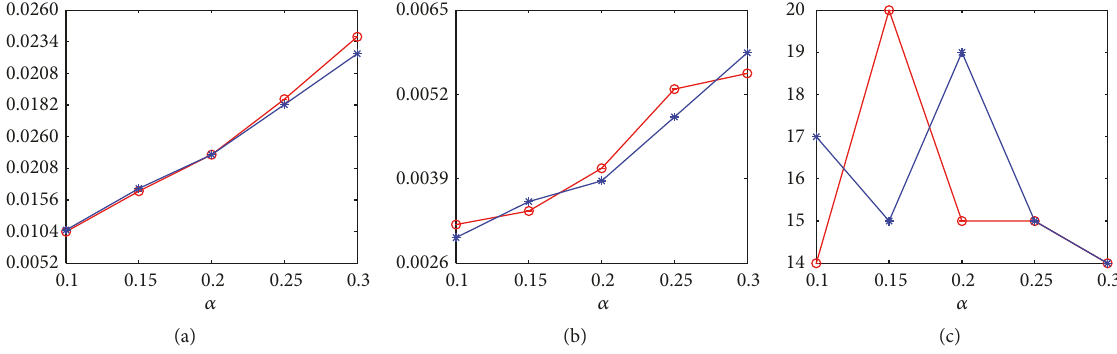
Figure 11: Comparison of three quantities of rumor propagation before and after deleting 4 nodes in Netsci (a) the average propagation size, (b) the average peak prevalence,and (c) the arrival time of the average peak prevalence(red circles represent the situation before deleting and blue stars represent the situation after